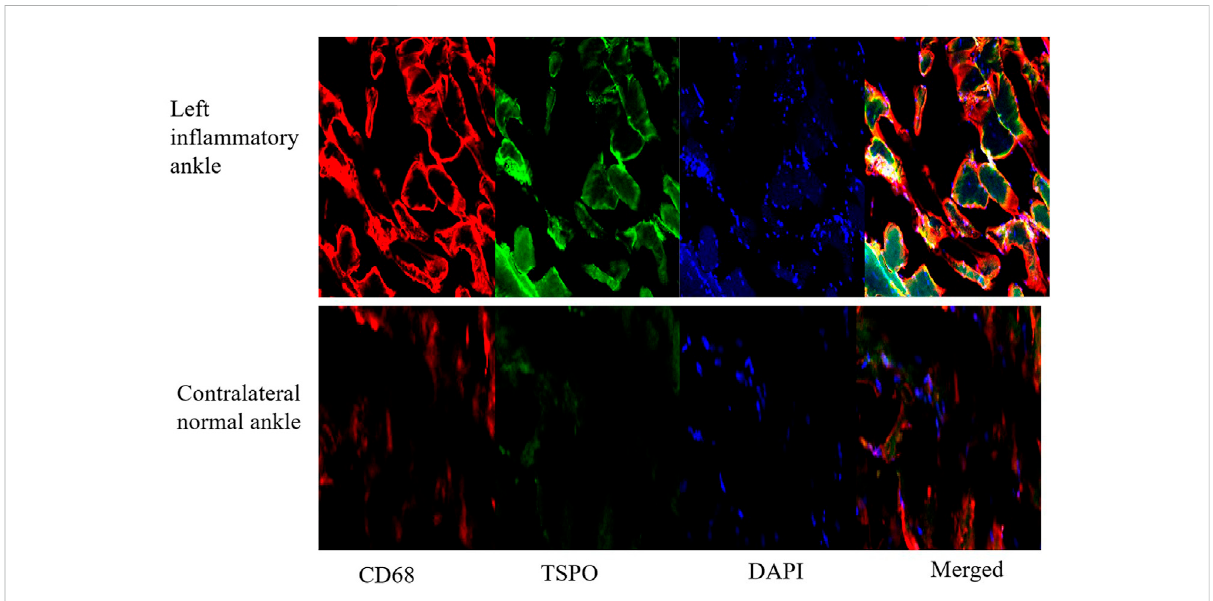
FIGURE 14 The expression of TSPO and CD68 on contralateral normal ankles by immuno fl uorescence staining